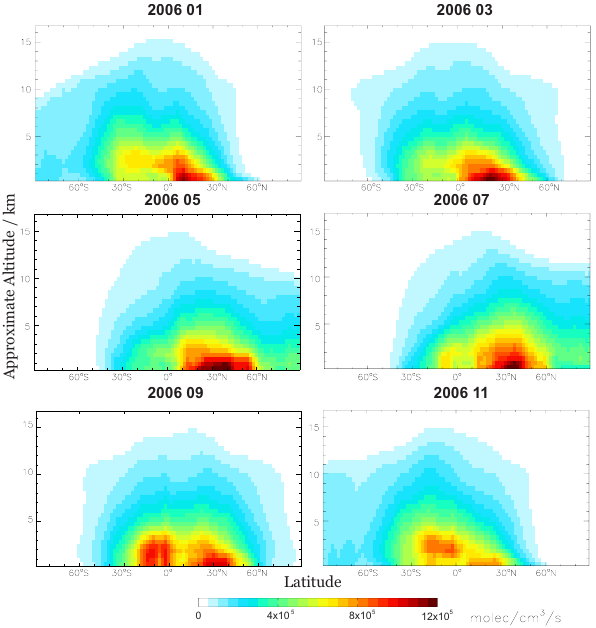
Fig. 6. Monthly vertical and latitudinal distribution of CO 2 chemical production for 2006. Altitudes are only approximate because they are based on conversion from model hybrid sigma